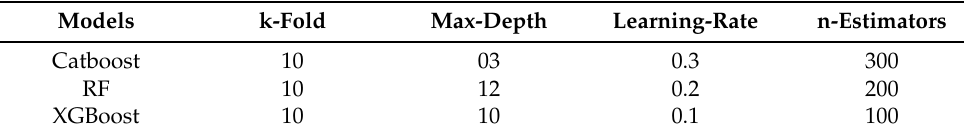
Table 2. Parameter settings for model tuning.